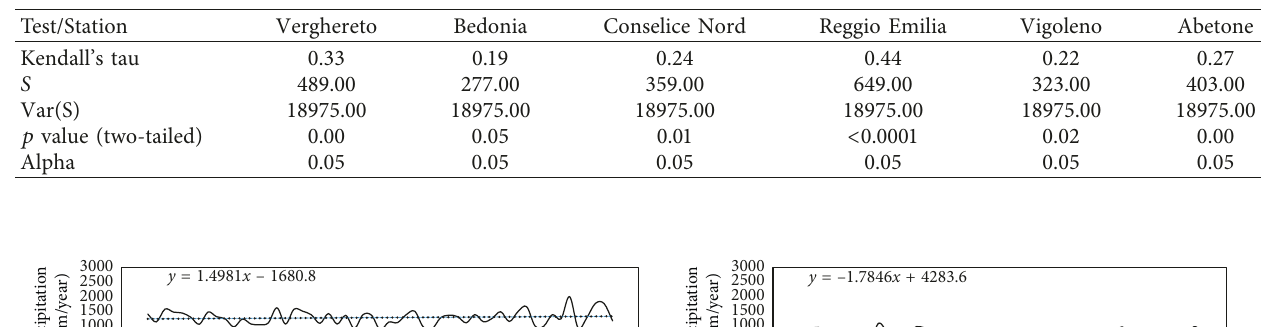
Table 3: The Mann-Kendall trend test statistic applied for annual minimum temperature observations.